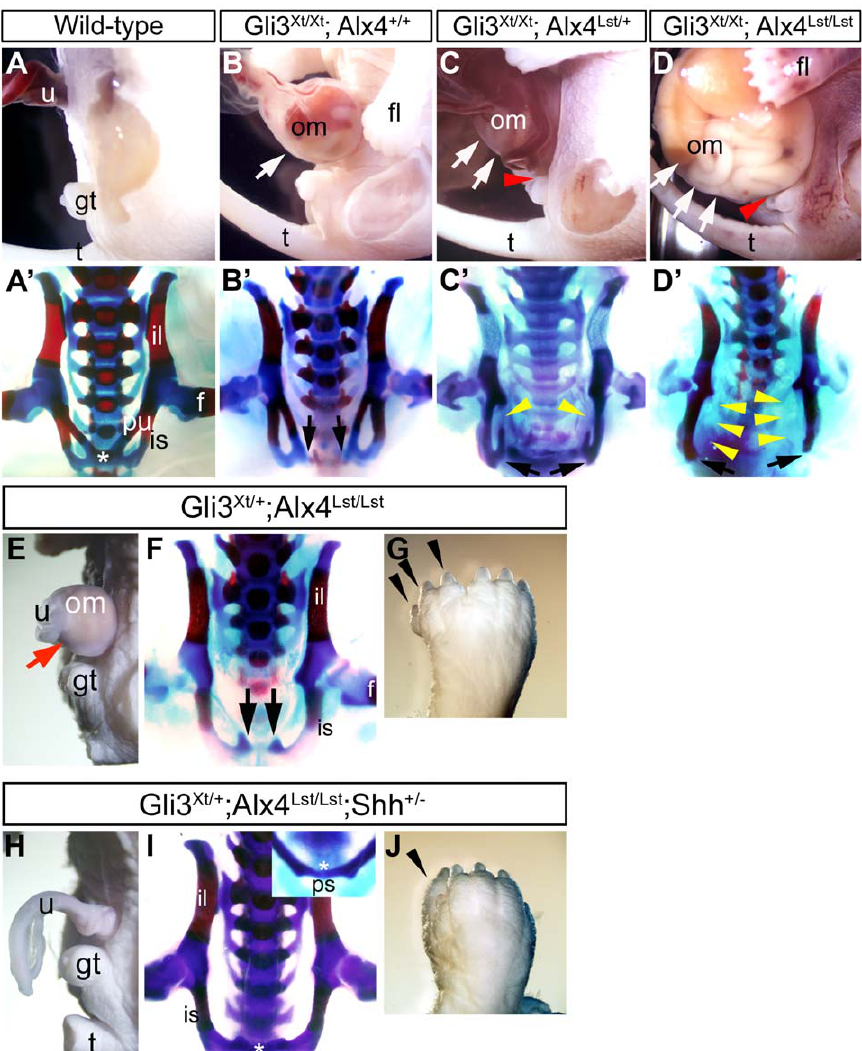
Figure 3. The omphalocele, pubic diastasis, loss of pubic bones and polydactyly in Gli3 Xt ;Alx4 Lst ;Shh combinatorial mutants. The lateral view of the embryonic ventral body wall ( A–D, E, H ) and frontal view of the pelvic girdle ( A’–D’, F, I ). Gli3 Xt/Xt embryos ( B ), Gli3 Xt/Xt ; Alx4 Lst/ + embryos ( C ) and Gli3 Xt/Xt ; Alx4 Lst/Lst embryos ( D ) showed a graded extent of omphaloceles by the introduction of additional Alx4 Lst alleles into the Gli3 Xt/Xt background ( B–D ; white arrows). The dorsal parts of the genital tubercle were hypoplastic in Gli3 Xt/Xt ; Alx4 Lst/ + and Gli3 Xt/Xt ; Alx4 Lst/Lst embryos ( C, D ; red arrowheads). The pubic symphysis of wild-type embryo was already formed at E18.5 ( A ’; asterisk). Pubic diastasis also became evident by the introduction of Alx4 Lst mutation ( B’–D’ ). Gli3 Xt/Xt ; Alx4 Lst/ + and Gli3 Xt/Xt ; Alx4 Lst/Lst embryos showed partial loss of pubic bone components ( C’, D’ ; yellow arrowheads). Black arrows indicate the unclosed pelvis. Gli3 Xt/ + ; Alx4 Lst/Lst embryos showed omphalocele ( E ; red arrow), severe polydactyly ( G ), pubic diastasis and loss of pubic bones ( F ). Black arrows show the unclosed pelvis. Gli3 Xt/ + ; Alx4 Lst/Lst ; Shh + / 2 embryos did not show omphalocele phenotypes ( H ). The pubic symphysis was formed but pubic bones were lost ( I ; asterisk). Polydactyly was still observed in Gli3 Xt/ + ; Alx4 Lst/Lst ; Shh + / 2 embryos ( J ). Black arrowheads indicate extra digits. f: femur, fl: fore limb, gt: genital tubercle, il: iliac bone, is: ischial bone, om: omphalocele, ps: pubic symphysis, pu: pubic bone, t: tail, u: umbilical cord.